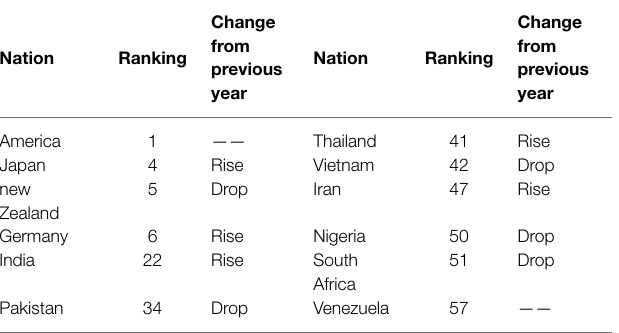
TABLE 11 | Economic risk ranking of overseas investing countries in